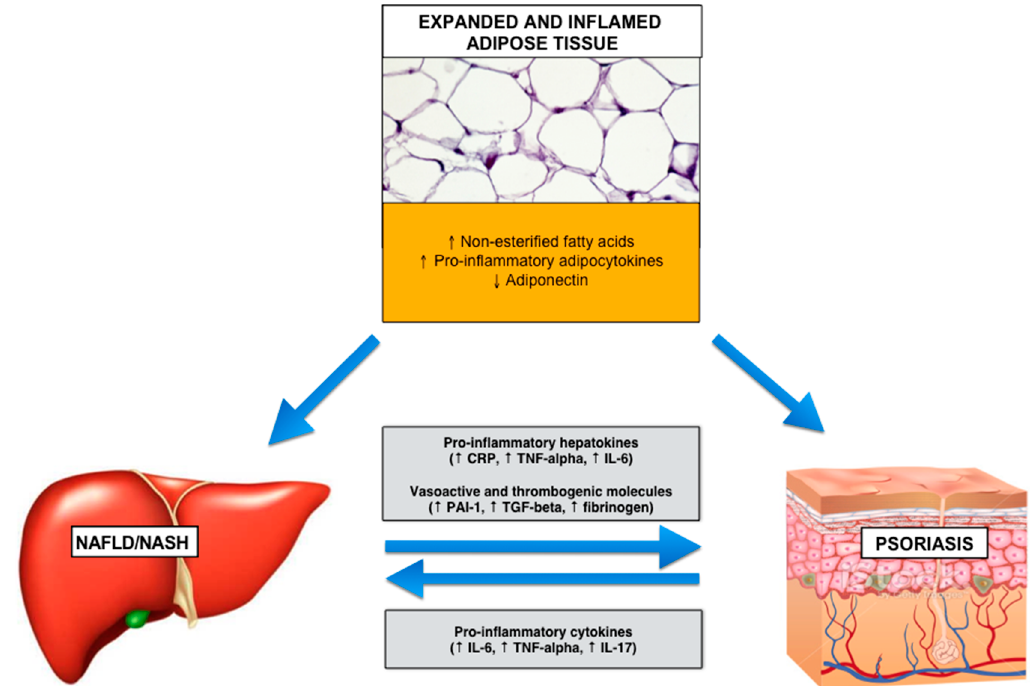
Figure 2. Possible mechanisms linking expanded and inflamed (dysfunctional) visceral adipose tissue, psoriasis and nonalcoholic fatty liver disease. Abbreviations: CRP, C-reactive protein; IL-6, interleukin-6; IL-17, interleukin-17; NAFLD, nonalcoholic fatty liver disease; NASH, nonalcoholic steatohepatitis; PAI-1, plasminogen activator inhibitor-1; TGF- β , transforming growth factor- β ; TNF- α , tumor necrosis factor- α .